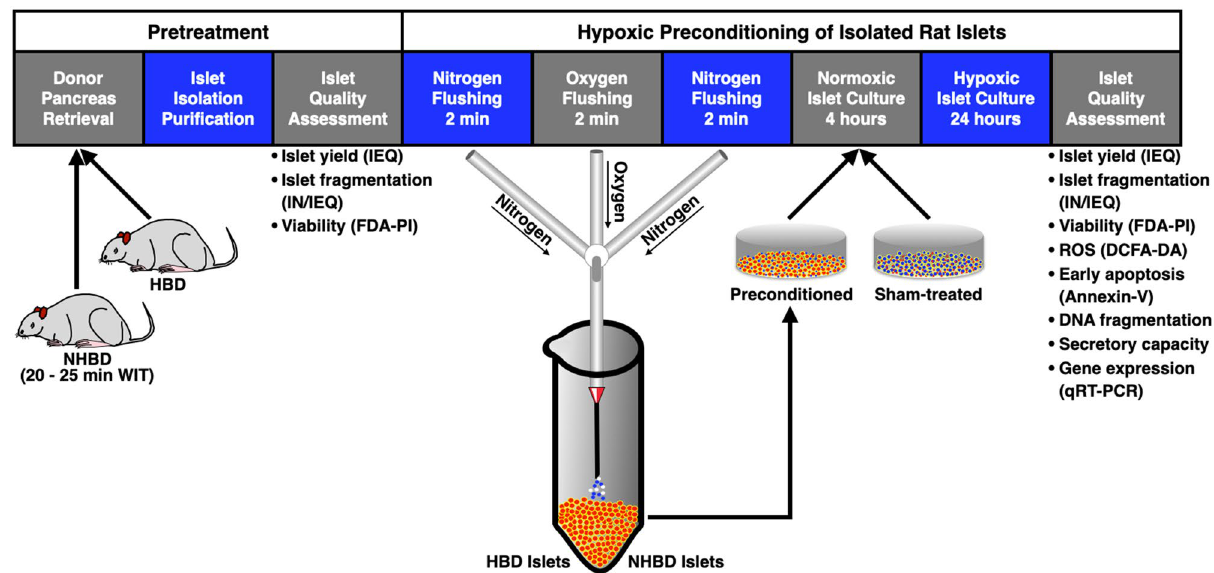
Figure 5. Experimental study design. Rat islets isolated from the pancreas of heart-beating (HBD, n = 7) and non heart-beating donors (NHBD, n = 14) were preconditioning in conical centrifuge tubes using alternating gassing of the islet suspension with nitrogen and oxygen for 2 min prior to recovery of 4 h of normoxic culture and subsequent exposure to hypoxia for 24 h followed by islet quality